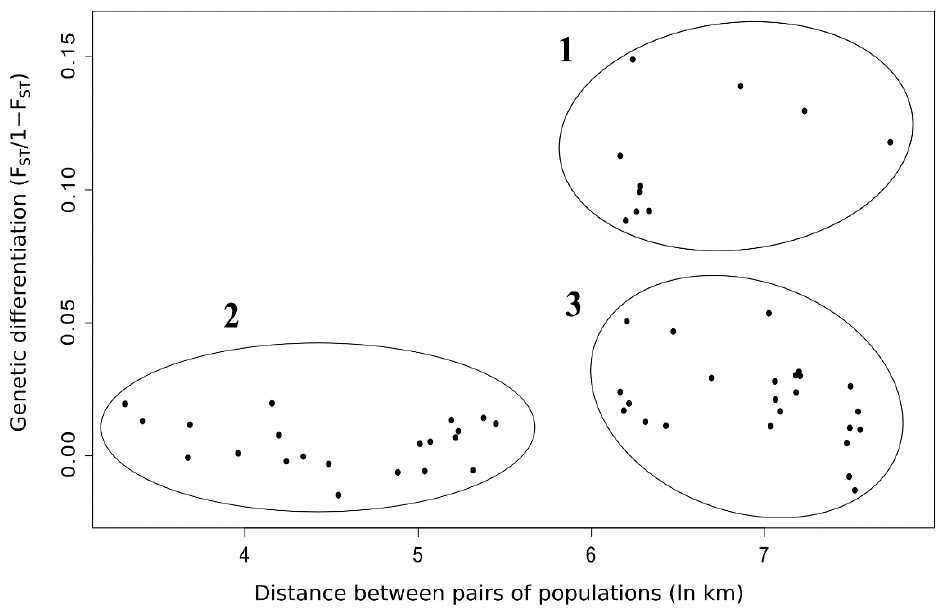
Figure 1. Relationship between pairwise population differentiation (F ST /1÷F ST ) and the geographic distance (ln km) separating populations. Ellipse 1 represents pairwise differentiations between U.K. and all other populations. Ellipse 2 represents pairwise differentiations between the French (Normandy) populations. Ellipse 3 represents pairwise differentiations between the French (Normandy) populations and the three populations from Central and Southern European countries (i.e., Switzerland, Czech Republic and Italy (Sicily) and among these three populations.